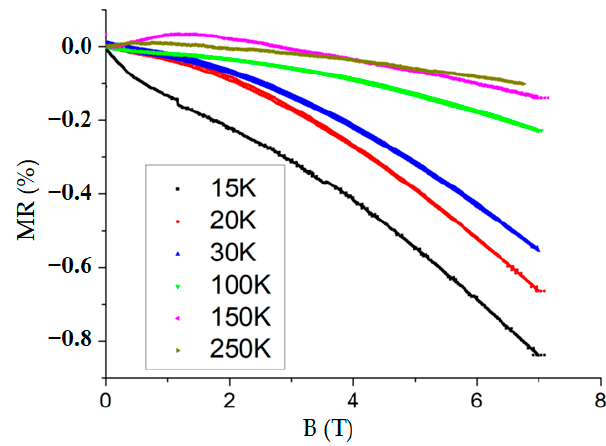
Figure 8. The MR measurement of Sample II.